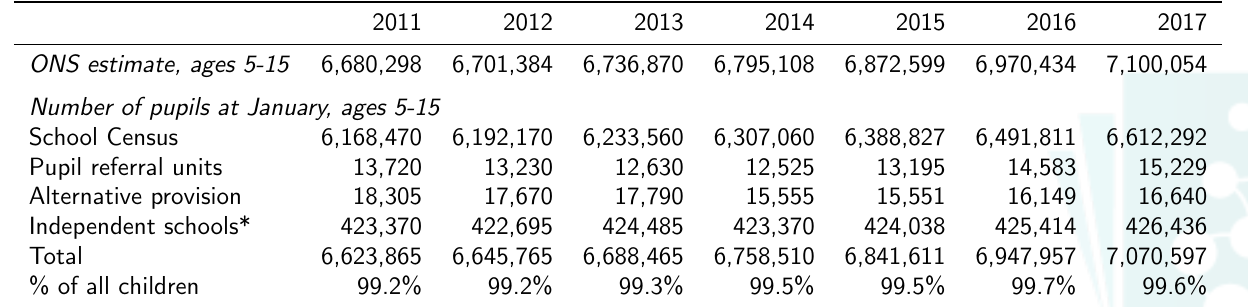
Table 4: Number of children of compulsory school age and number of children identified in the National Pupil Databases school